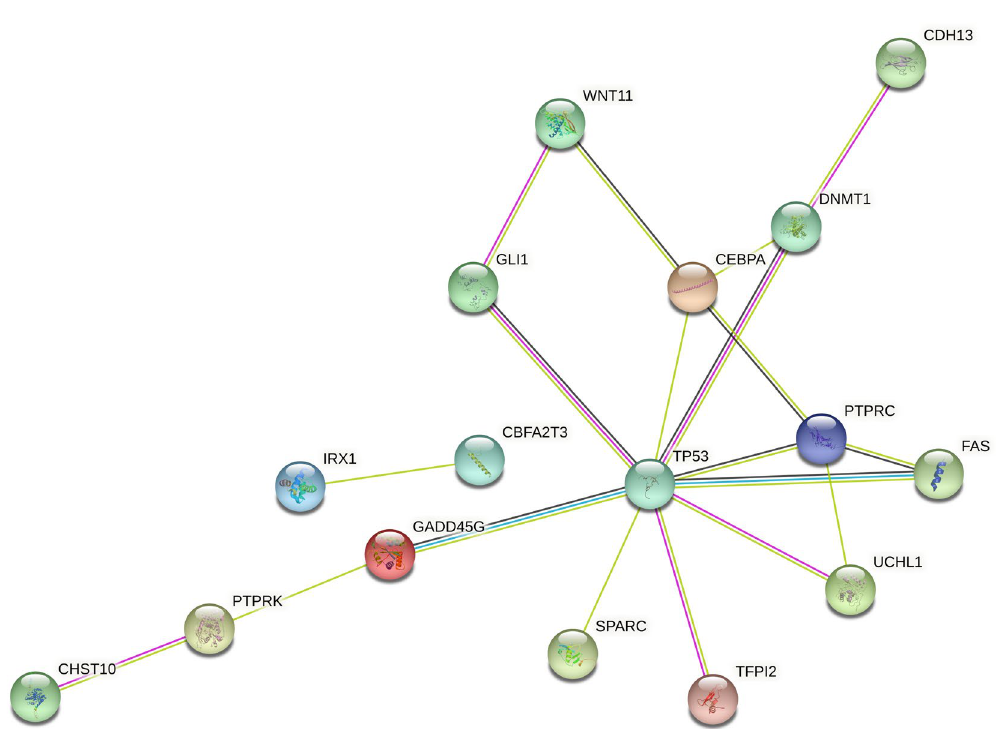
Figure 5. Network of interaction between tumor suppressor and p53 gene. The network was established by the STRING database (version 11.5, https:// cn. string- db. org/) and visualized in the Cytoscape software (version 3.4.0, http:// www. cytos cape.